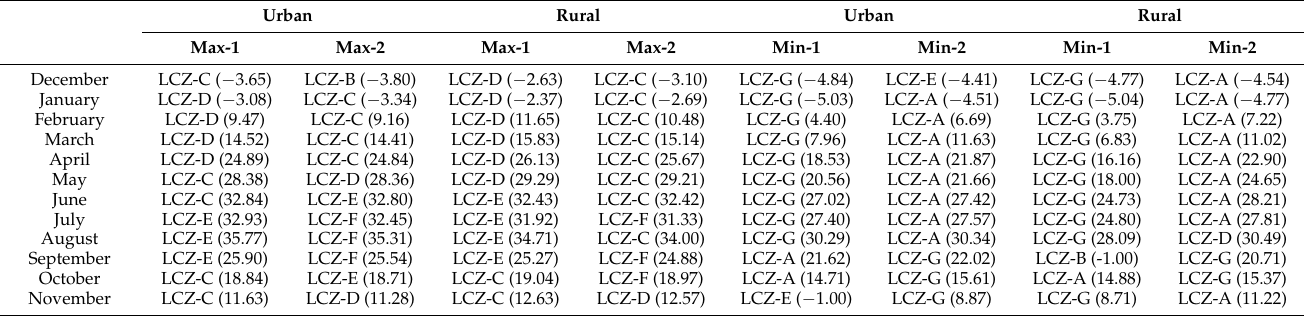
Note: Max-1 means the highest temperature and Max-2 means the second highest temperature. Min-1 means the lowest temperature and Min-2 means the second lowest temperature. LCZ-A, Dense trees; LCZ-B, Scattered trees; LCZ-C, Bush, scrub; LCZ-D, Low plants; LCZ-E, Bare rock or paved; LCZ-F, Bare soil or sand; LCZ-G,